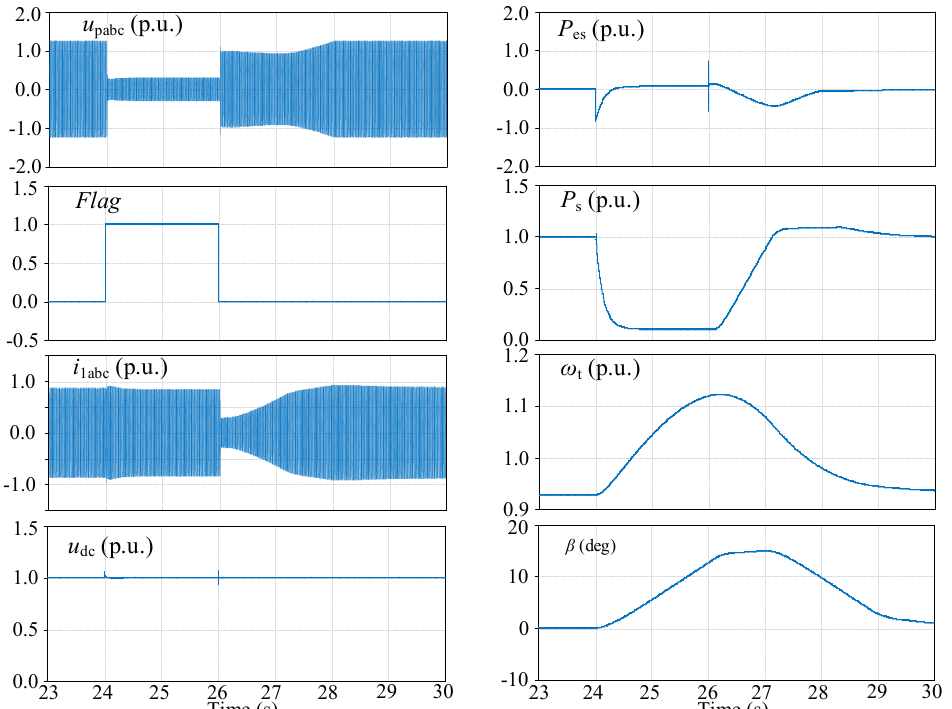
Figure 11. Simulation results of the wind turbine’s LVRT based on the virtual resistor control.